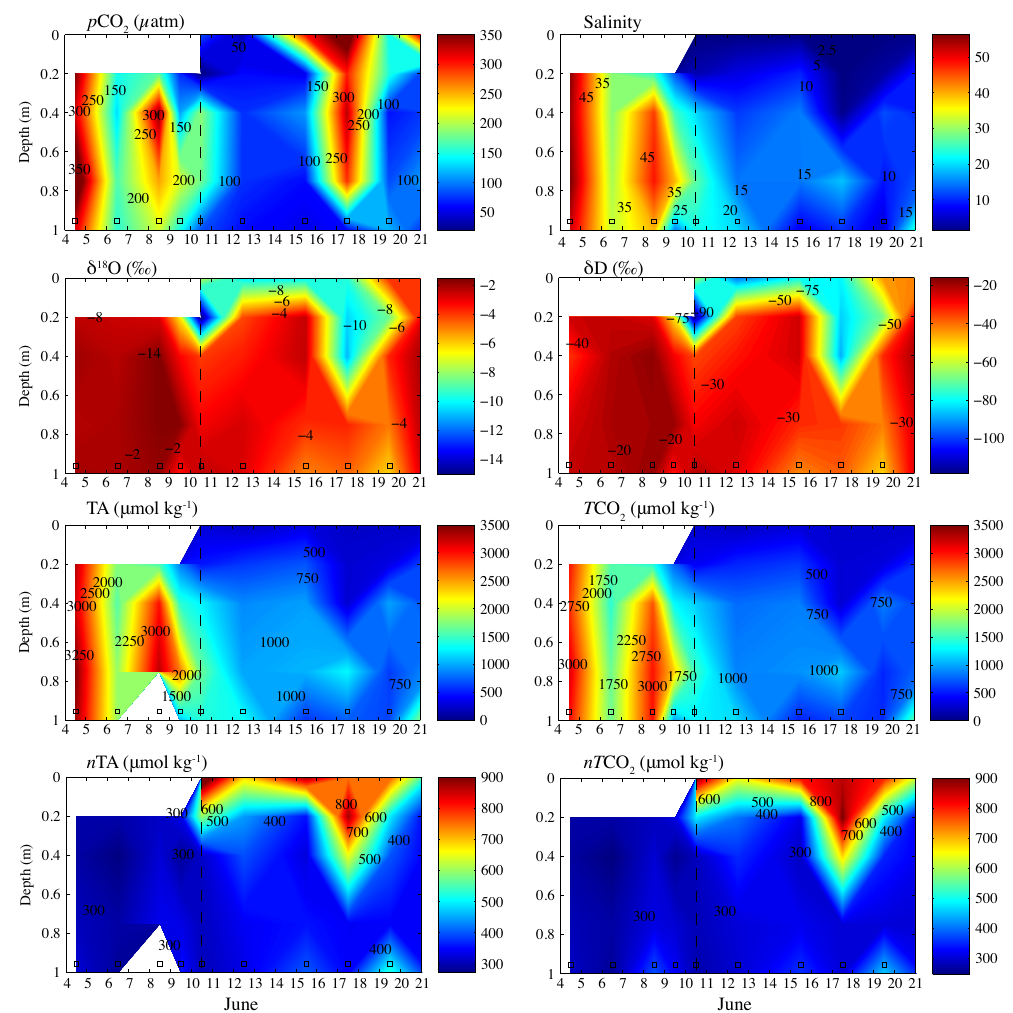
Figure 5. Temporal evolution of brine (0.2, 0.4, 0.75 and 1m depth) and melt ponds (0m) p CO 2 [in situ] (µatm), salinity, isotopic composition of δ 18 O and δD (‰), TA and n TA (µmolkg − 1 ), T CO 2 and nT CO 2 (µmolkg − 1 ). Open squares on the x axis mark the sampling dates.